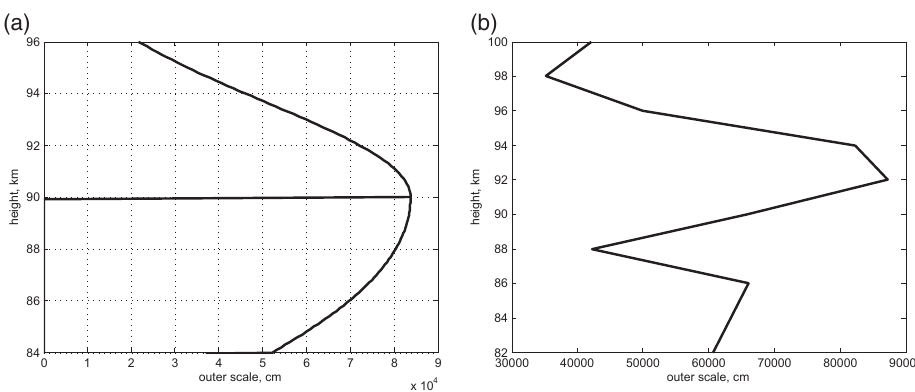
Figure 2. (a) The outer scale calculated by Eq. (14) with the ε and K ed values given in Table 3 (summer) in Lübken (1997) and approximated, as can be seen from Figs. A1 and A2 in Appendix A. (b) The same as in Fig. 2a but using the ε and K ed values in winter given in Table 4 in Lübken (1997).